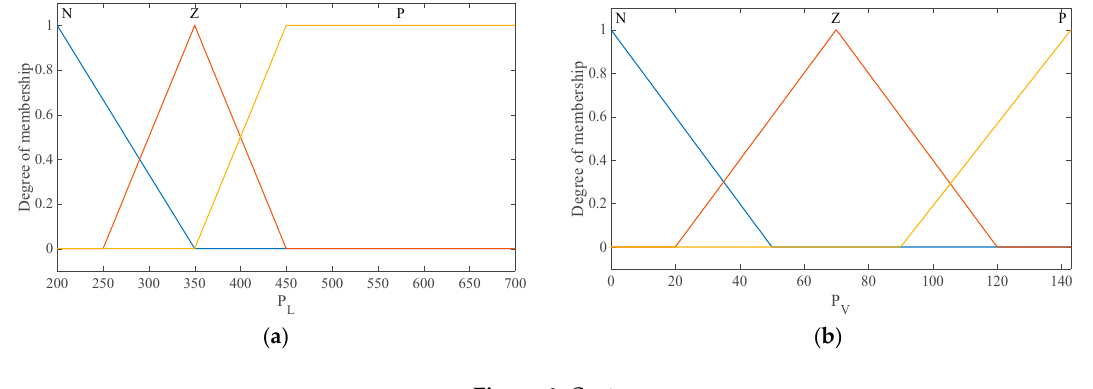
Figure 5. Structure of the energy management strategy based on fuzzy logic.